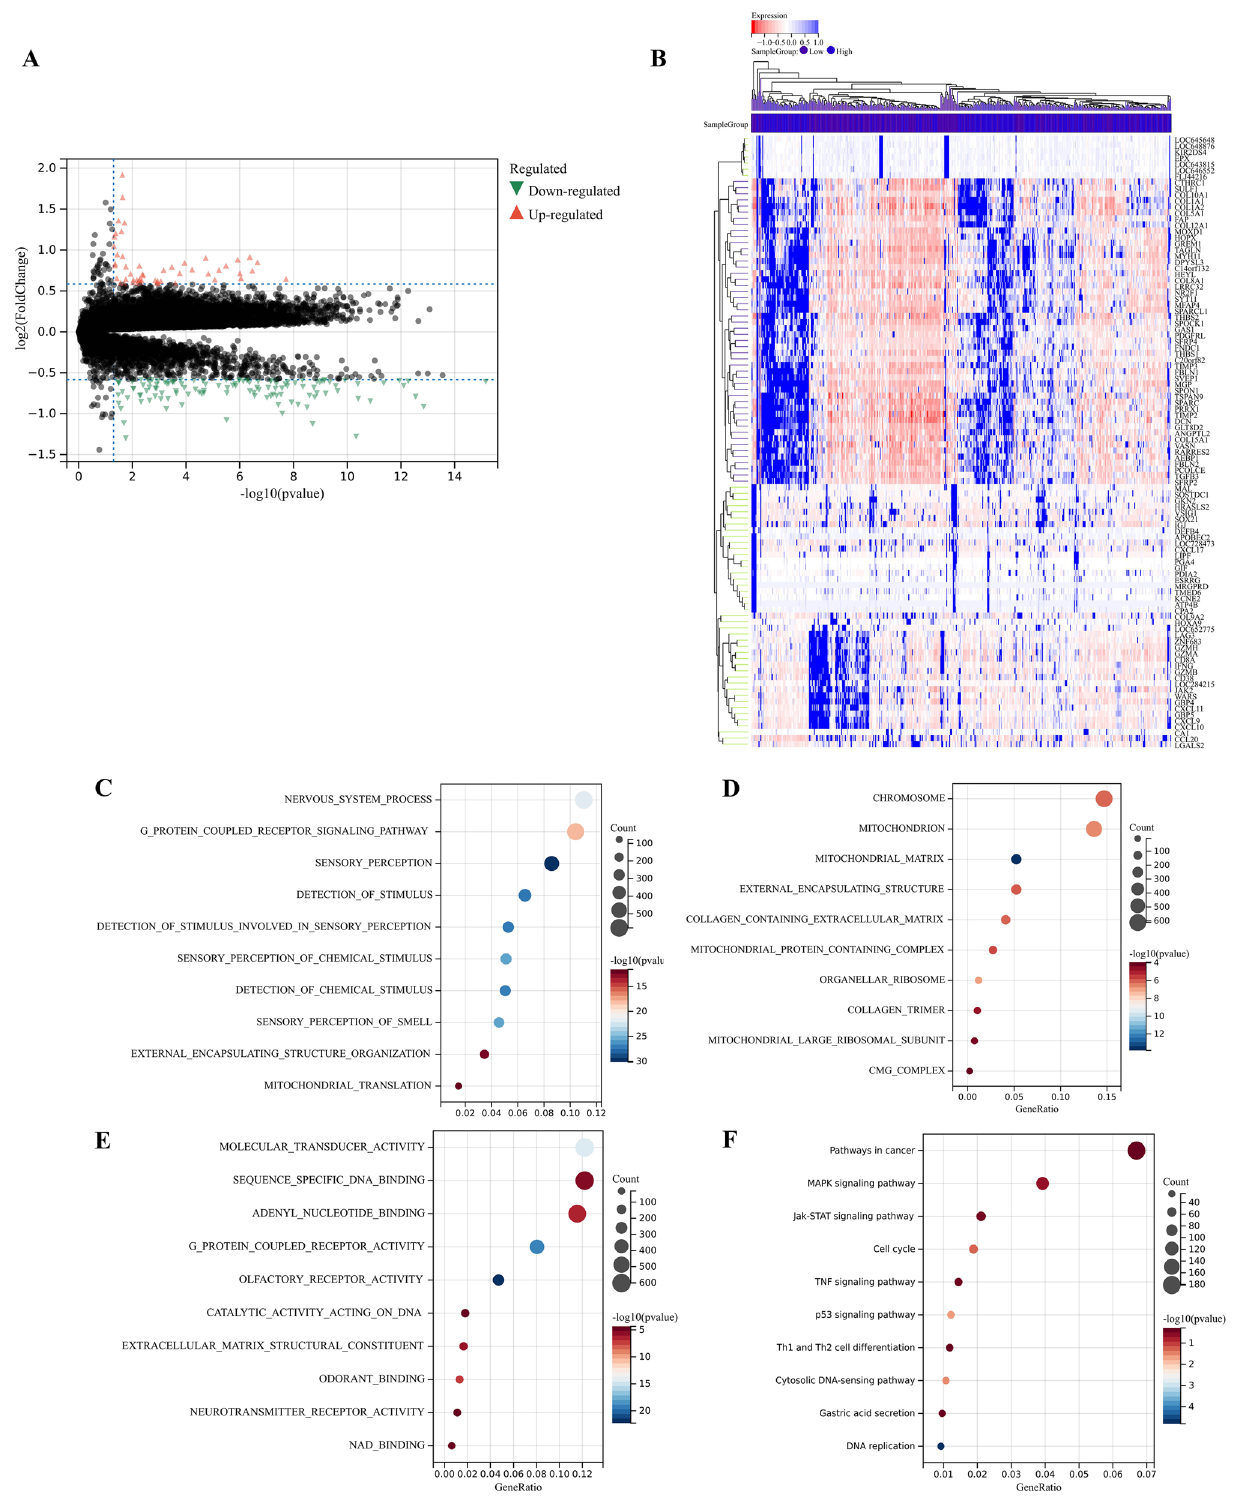
Figure 10. Identification of DEGs and functional enrichment analysis in GEO cohorts (www. kegg. jp/ kegg/ kegg1. html). ( A ) The volcanic map of DEGs. ( B ) The heatmap of DEGs. ( C – F ) The BP, CC, MF, and the whole GO of